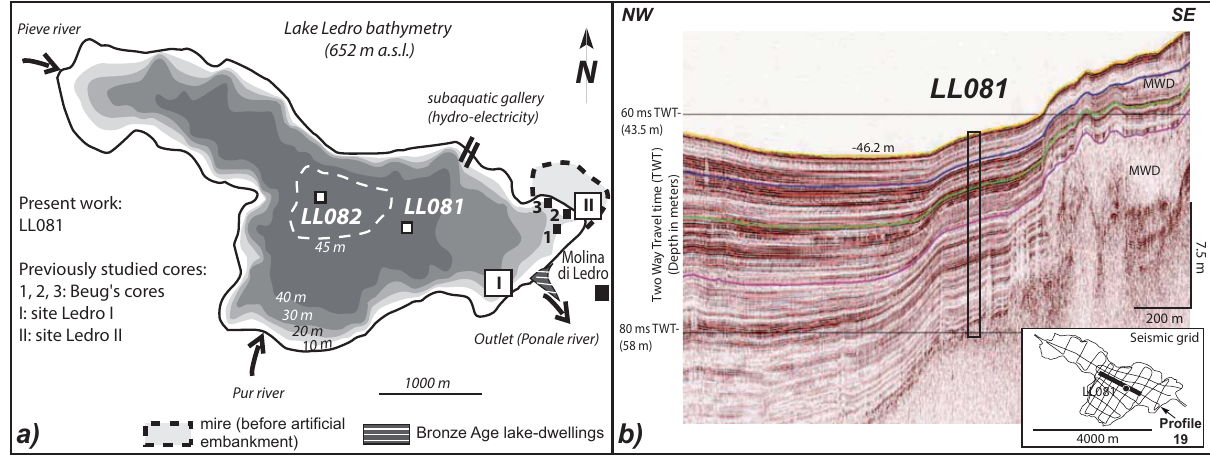
Fig. 2. Main characteristics of the Lake Ledro basin fill: (a) Lake Ledro bathymetry showing the Pieve and Pur River deltas, and collection location of the LL081 (this study) and LL082 (Simmoneau et al., 2012; Vanni ` ere et al., 2012) sediment cores and of previously studied sites from Beug (1964) (1–3) and Magny et al. (2009) (I–II); (b) seismic reflection profile from Lake Ledro illustrating well-preserved basin fill geometry at site LL081, i.e. away from tributary deltas and mass wasting deposits (MWD).